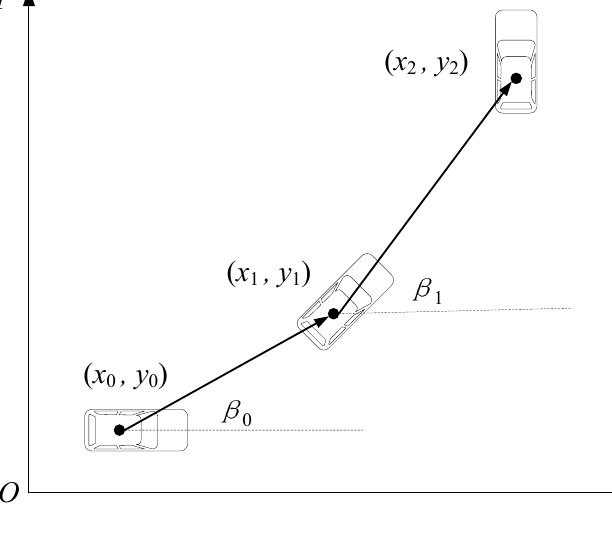
Figure 4. Schematic diagram of dead reckoning.